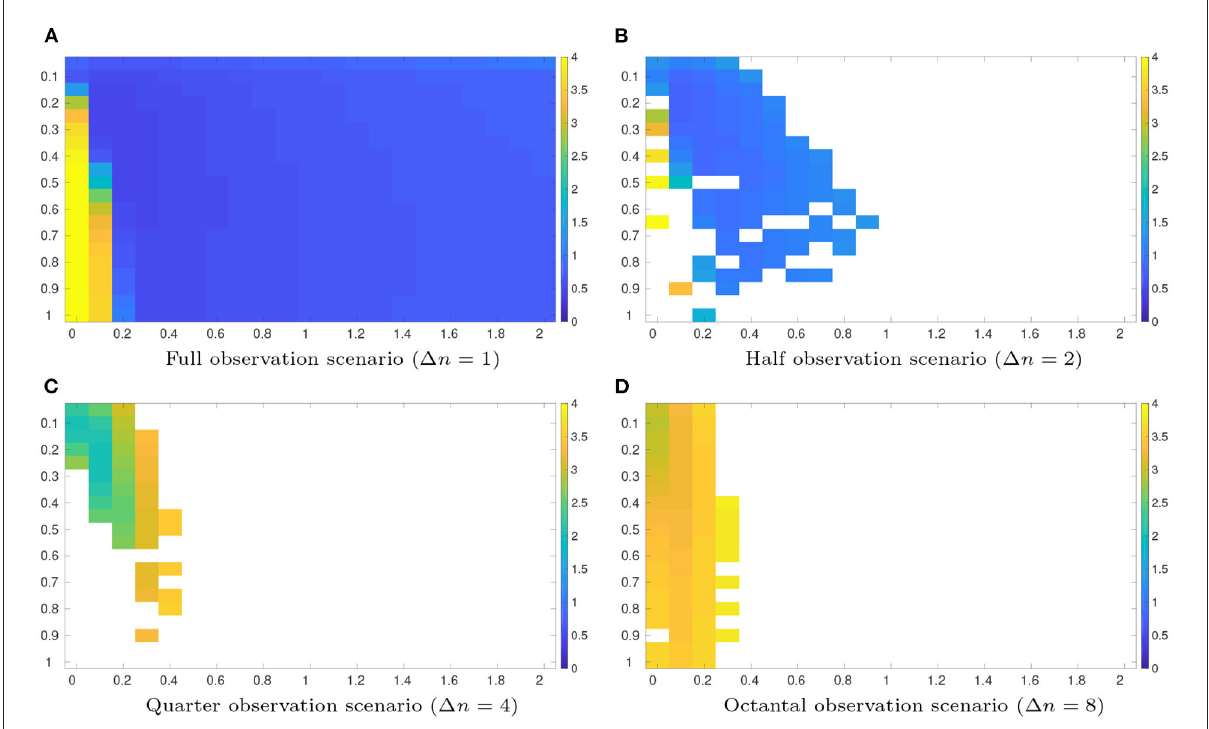
FIGURE2 As in Figure 1, but for average RMSEs obtained by the grid search method in the half ( 1 n ( 1 n 8, N freq 4) observation scenarios, respectively, with the ensemble sizes N e = = observation scenario ( 1 n 1, N freq 4, N e 30) in Figure 1 are re-plotted here. (A) Full observation scenario ( 1 n = 1). (B) Half observation = = = scenario ( 1 n = 2). (C) Quarter observation scenario ( 1 n = 4). (D) Octantal observation scenario ( 1 n = 8).